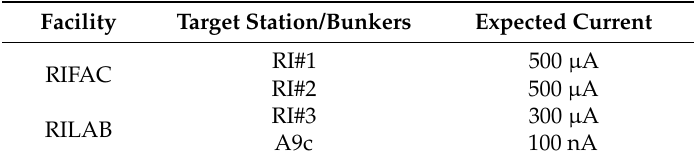
Table 1. Proton-beam characteristics of the four LARAMED beamlines with a tunable energy of 35–70 MeV each.